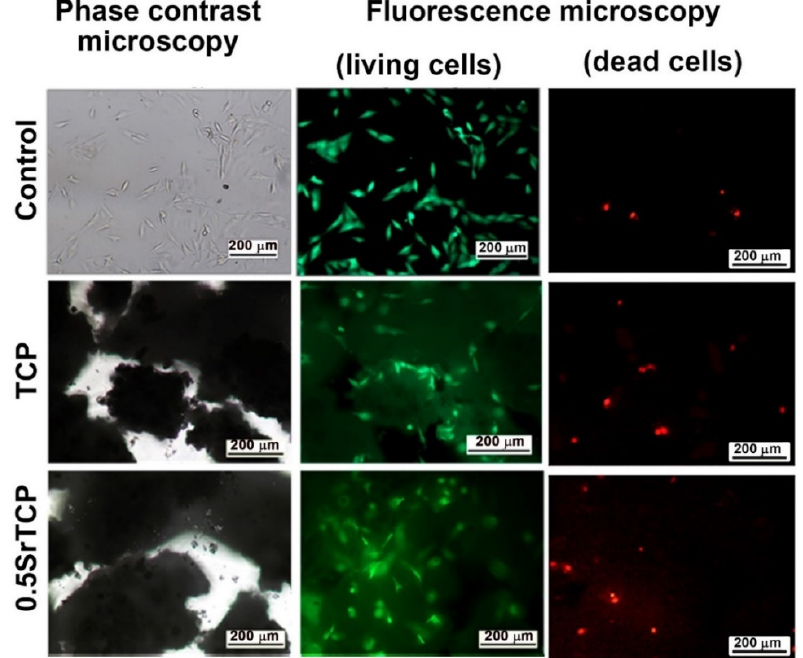
Figure 10. Fluorescence microscopy of living ( green ) and dead ( red ) MG-63 cells in direct contact with TCP and 0.5SrTCP ceramics (live/dead assay, 24 h of cell growth). Spreading and adhesion of the osteoblast-like MG-63 cells on TCP and 0.5SrTCP ceramic surfaces were evaluated after 24 h of cell seeding (Figures 11 and 12). The shape and area of spreading of cells were studied by means of fluorescence microscopy. As one can observe from Figures 11 and 12, the MG-63 cells vary in their shape; the cells are larger in size and of a polygonal osteoblast-like shape in the control group and smaller in size and mainly of a polygonal shape on the surfaces of the TCP and 0.5SrTCP ceramics. The area of spreading is almost twice as much as for the control sample (Figure 11). A comparison of the results obtained for TCP and 0.5SrTCP ceramics (Figure 11) shows that the cell spreading area was the same for both the ceramic materials, but the cell osteoblast-like shape (Figure 12) was more characteristic for the 0.5SrTCP ceramic.